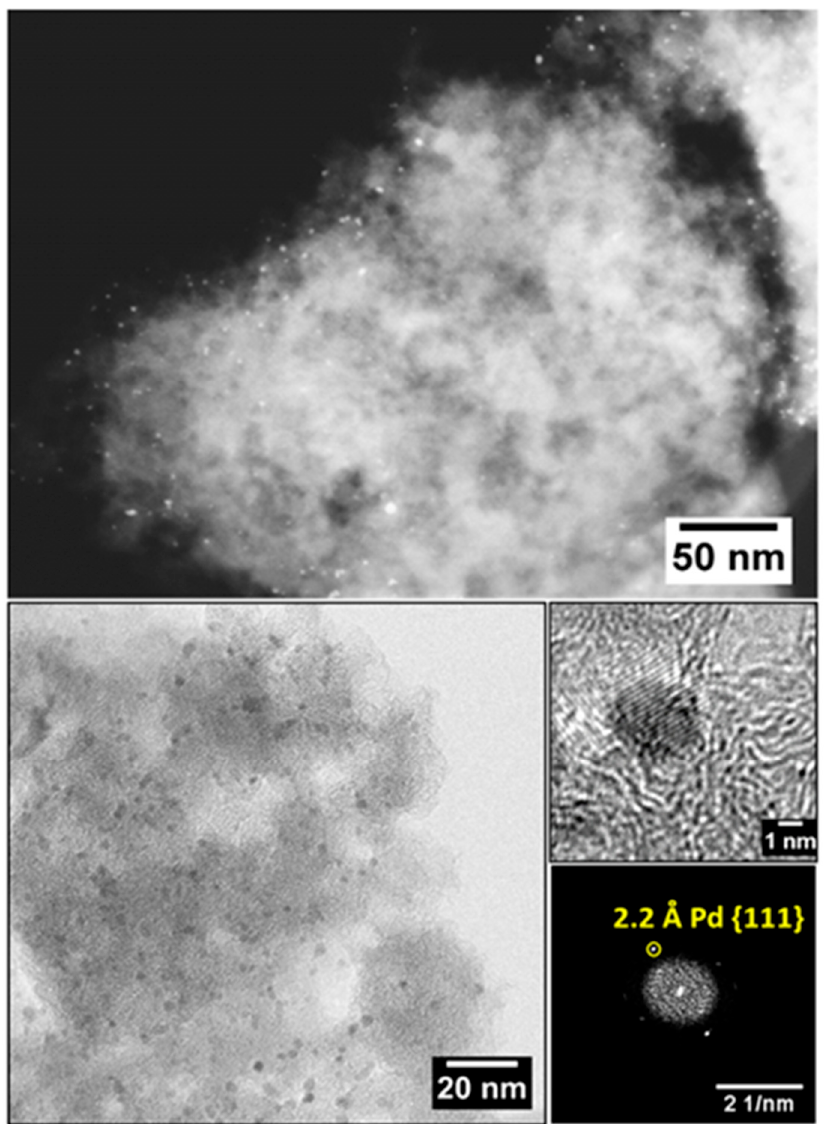
Figure 6. Representative HAADF-STEM ( top ) and TEM ( bottom, left ) microphotographs of Pd/C and HR-TEM of a Pd NP with corresponding FFT pattern ( bottom, right ).